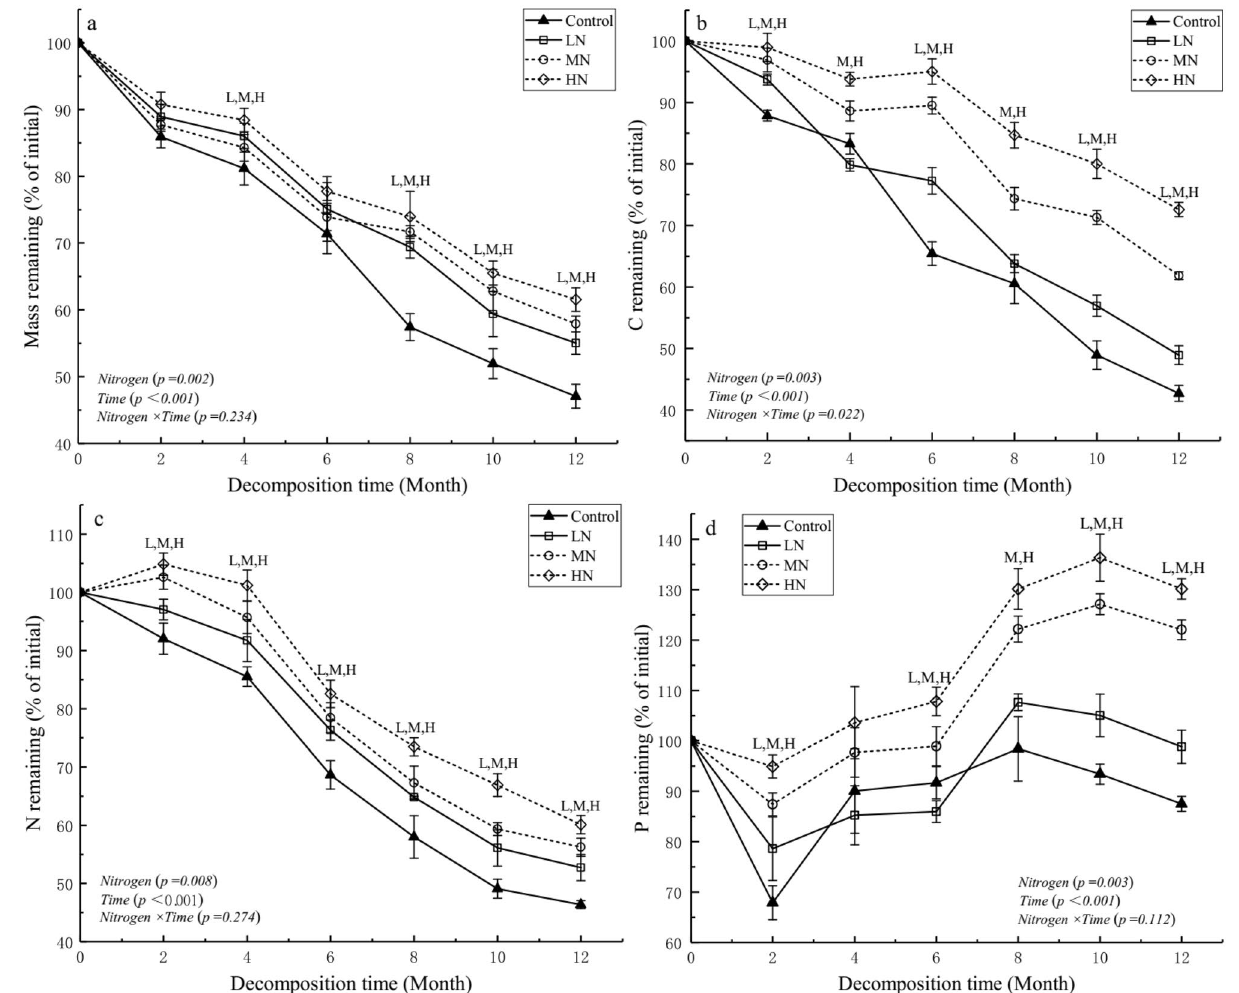
Figure 1. Effects of simulated N deposition on the dynamics of mass, carbon, nitrogen, phosphorus remaining in decomposing leaf litter. Values are expressed as mean ± standard error (SE) (n = 3). LN, MN, and HN treatments at each decomposition time indicated that the difference between N treatments and control treatment is significant ( P < 0.05).